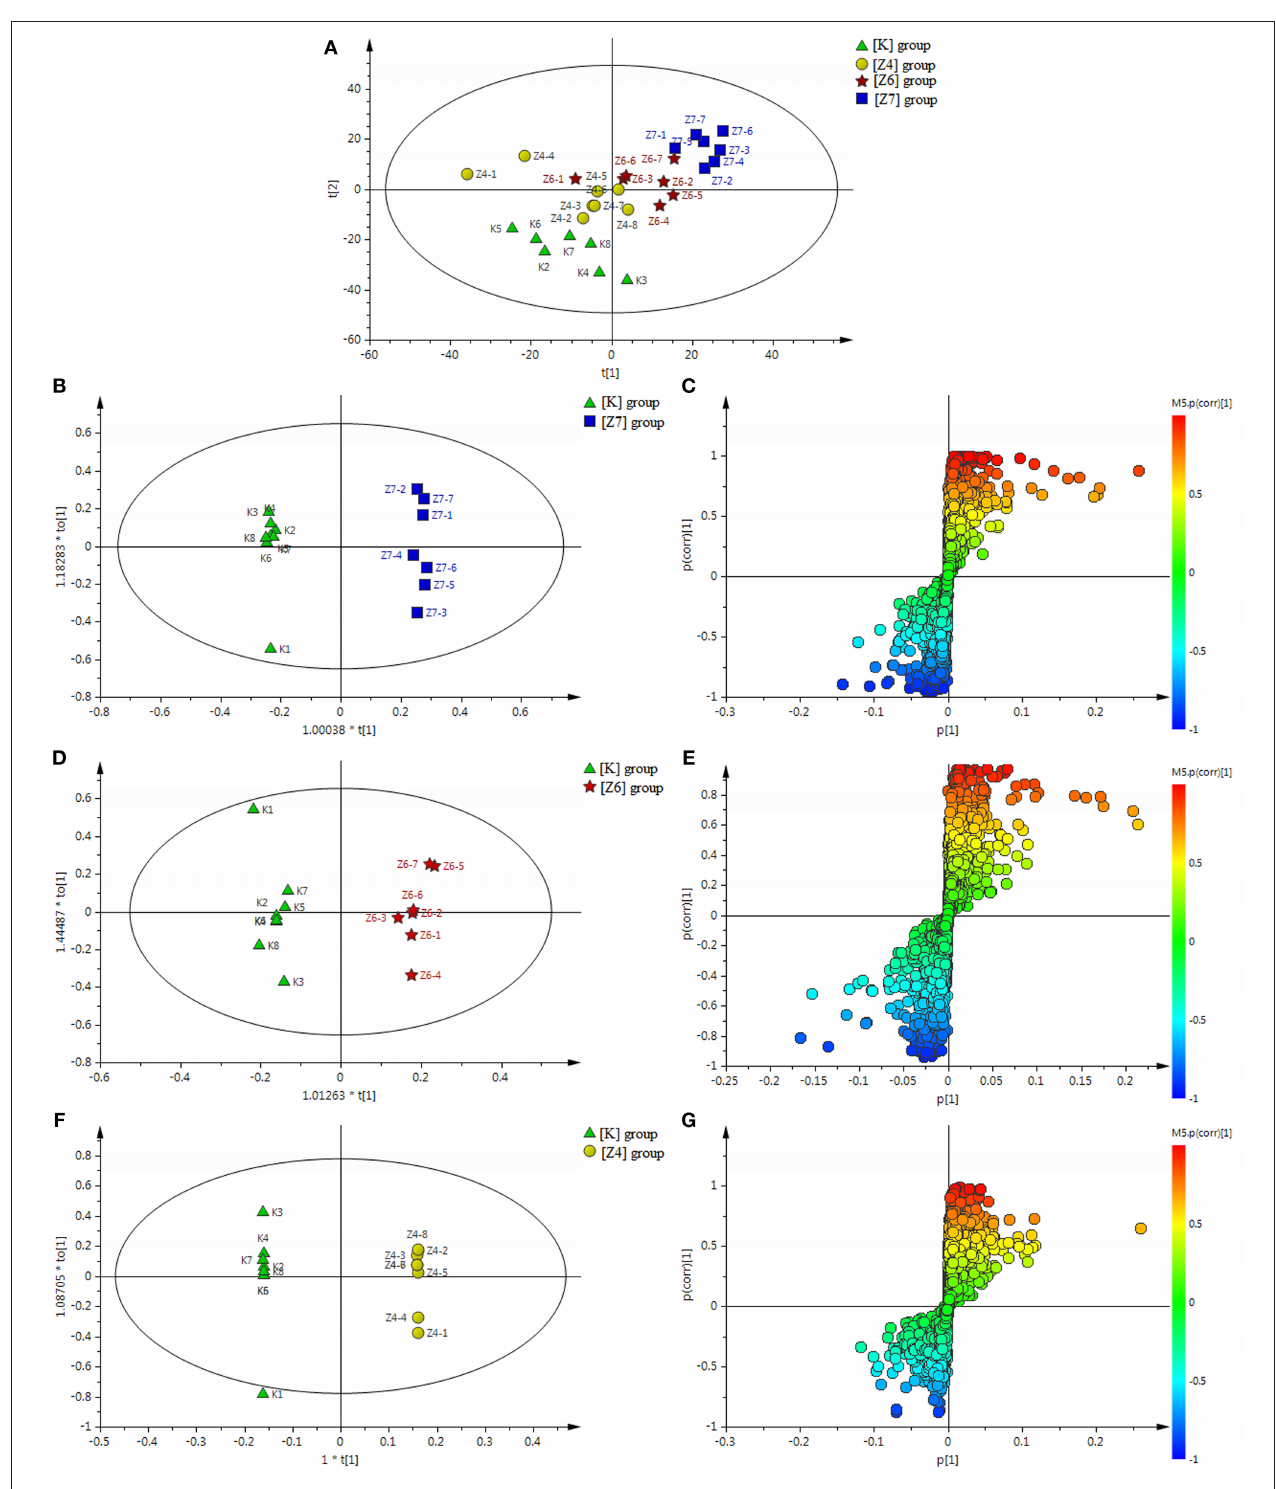
FIGURE 6 | (A) Results of multiple pattern recognition of serum metabolites of healthy rats with or without exposure to PBR. PCA score plot ( n = 8, R 2 X = 0.453, Q 2 = 0.0152). (B) OPLS score plot ( n = 8, R 2 Y = 0.997, R 2 X = 0.0.504, Q 2 = 0.873) of [Z7] group and [K] group and the corresponding OPLS S-plot (C) . (D) OPLS score plot ( n = 8, R 2 Y = 0.974, R 2 X = 0.0.29, Q 2 = 0.558) of [Z6] group and [K] group and the corresponding OPLS S-plot (E) . (F) OPLS score plot ( n = 8, R 2 Y = 1, R 2 X = 0.699, Q 2 = 0.505) of [Z4] group and [K] group and the corresponding OPLS S-plot (G) . Each triangle in the S-plot represents an ion. Ions far away from the origin were potential